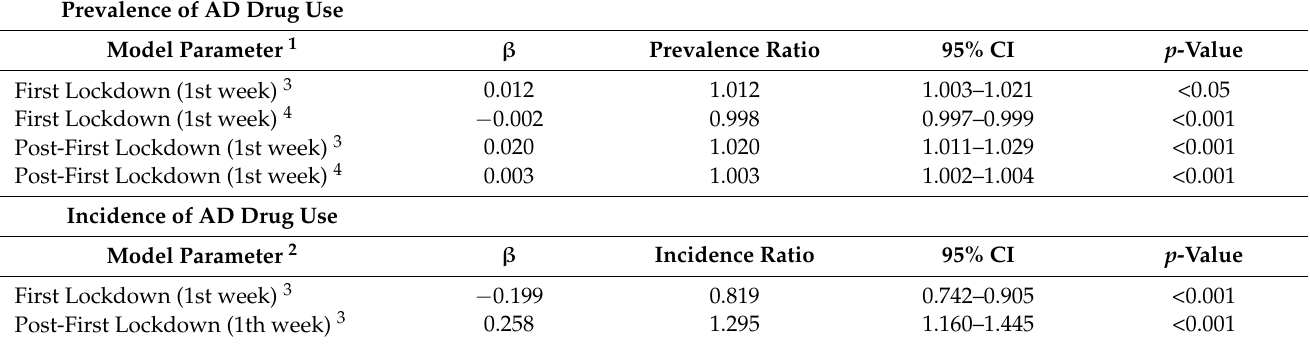
Table 1. Time series analysis of antidepressants drug use across different time segments: Pre-Lockdown, First Lockdown, Post-First Lockdown and Second Lockdown.